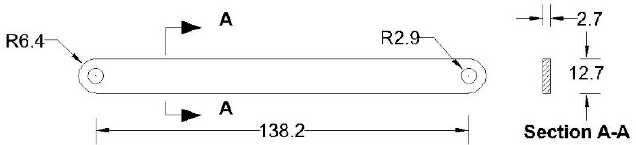
Figure 10. Details of Sidebars (all dimensions are in mm, steel plate gauge 12).